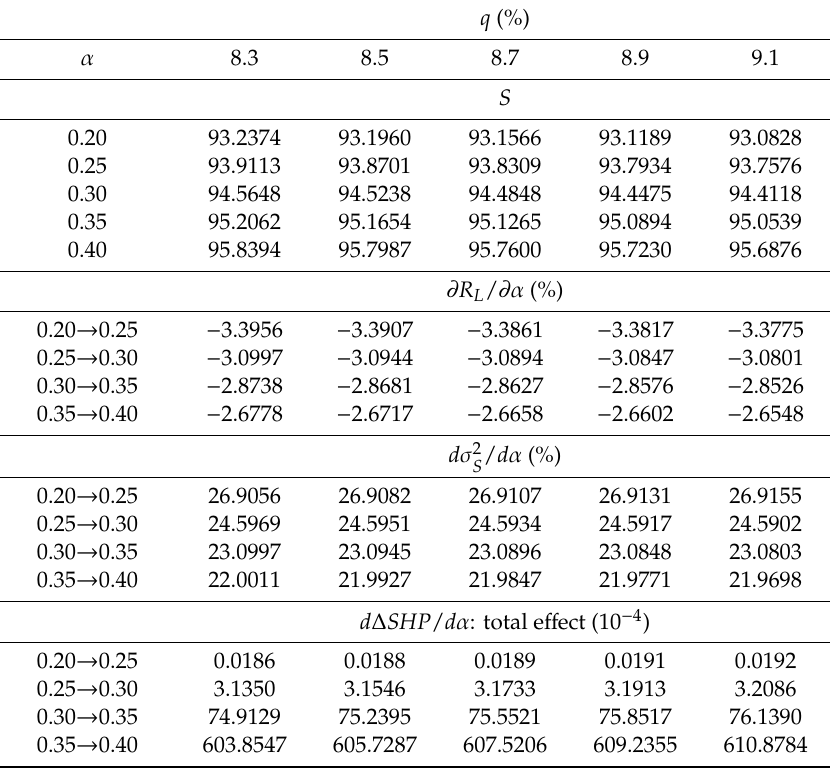
Table 4. E ff ects of international loan portfolio diversification degree on diversification e ffi ciency at various levels of capital-to-deposits ratio.